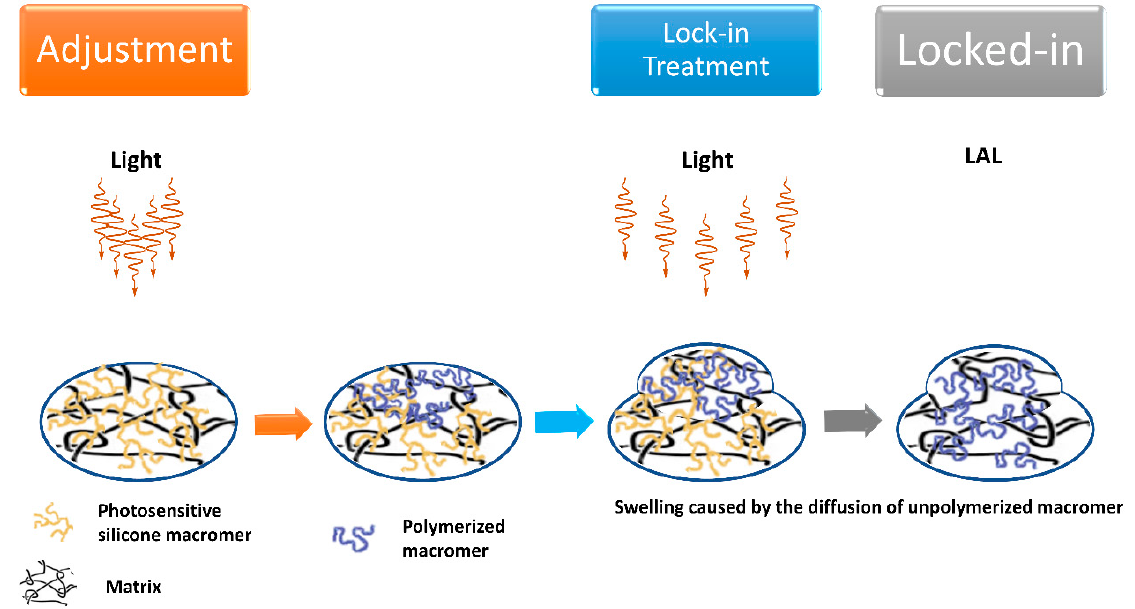
Figure 5. Scheme for new technology for making postop IOL adjustments.